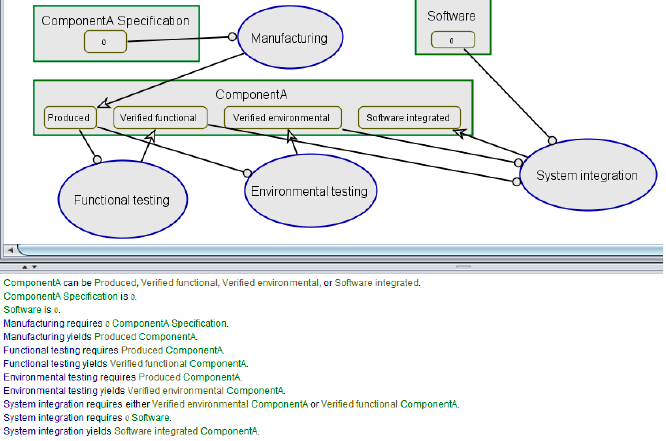
Figure 9. Complete process description OPM model, after making use of Process Oriented Viewpoint for Engineering (PROVE) methodology.